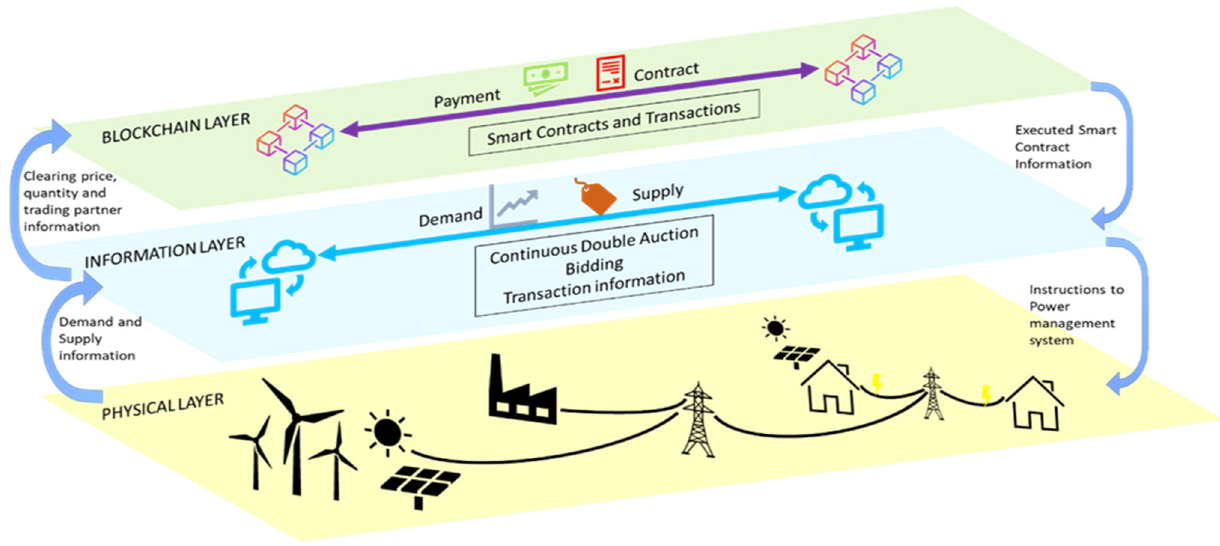
Figure 3. A type of blockchain-based decentralized energy distribution system. It can be seen how various areas of research discussed in this article fit together to form a blockchain-based energy distribution system.